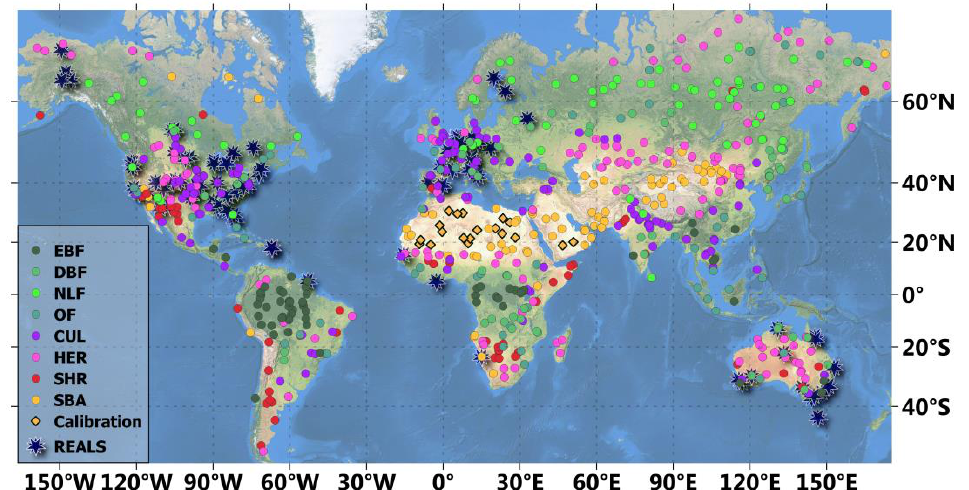
Figure 1. Global distribution of 99 REALS and 720 LANDVAL (including 19 desert calibration) sites used for product intercomparison and direct validation, respectively. LADNVAL are displayed as per biome type: EBF stands for evergreen broadleaved forest, DBF for deciduous broadleaved forest, NLF for needle-leaf forests, OF for other forests, CUL for cultivated, HER for herbaceous, SHR for shrublands, and SBA for sparse and bare areas.